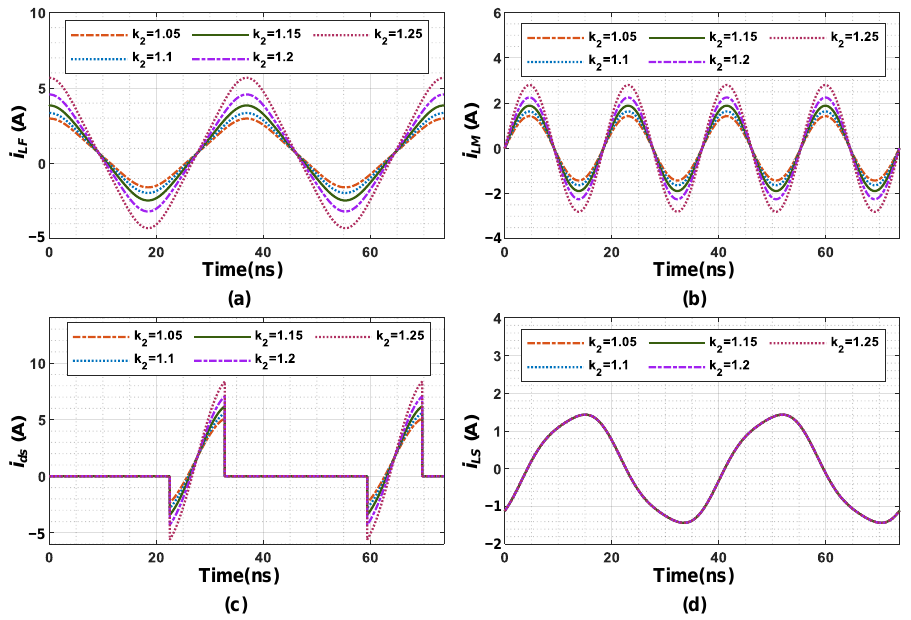
k 2 > 1. To leave a margin for ZVS, k 2 is selected as 1.1.